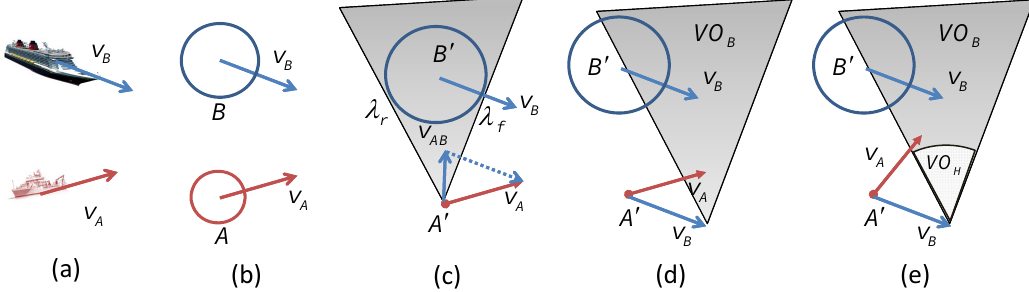
Figure 1. Illustration of the Velocity Obstacle (VO) model. ( a ) Ship A is a Maritime Autonomous Surface Ship (MASS), and ship B is a conventional ship, which are moving in velocity vector v A and v B , respectively; ( b ) represents the geometric shapes of the two ships by circles; ( c ) represents the collision region by relative velocity: if the relative velocity vector v AB falls into the shaded area, the MASS A may collide with the ship B ; ( d ) represents the collision region by the absolute velocity vector of A , i.e., if the velocity vector v A ends in the shaded area, the MASS A may collide with B ; ( e ) the velocity obstacle VO B for a short time